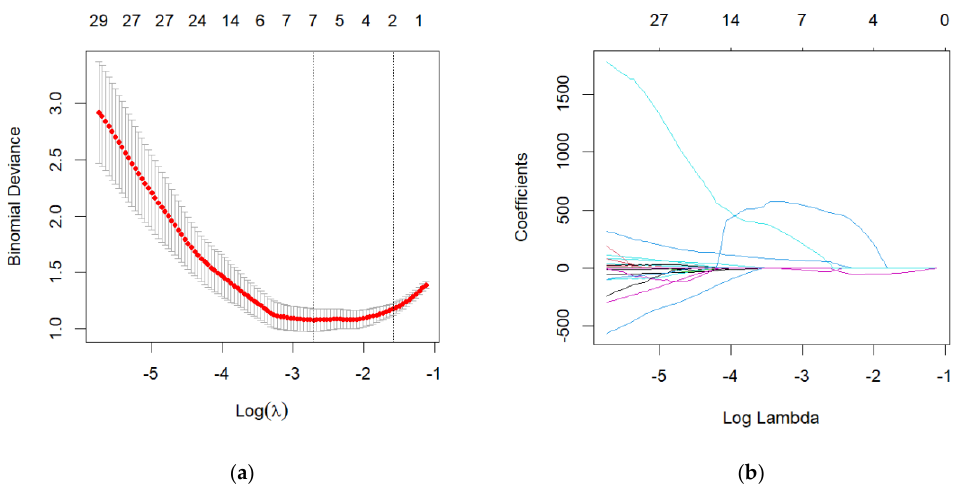
Figure 3. Radiomic feature selection using the least absolute shrinkage and selection operator (LASSO) binary logistic regression model. ( a ) Tuning parameter ( λ ) selection in the LASSO model used 5-fold cross-validation via minimum criteria. The binomial deviance was plotted versus log ( λ ). Dotted vertical lines were drawn at the optimal values using the minimum criteria and the standard error of the minimum criteria (the 1 − SE criteria). According to 5-fold cross-validation, the minimum criteria ( λ = 0.06656, log ( λ ) = − 2.700) were chosen for selection of radiomic features. ( b ) LASSO coefficient profiles of the 7 selected features. A coefficient profile plot was produced against the log ( λ )